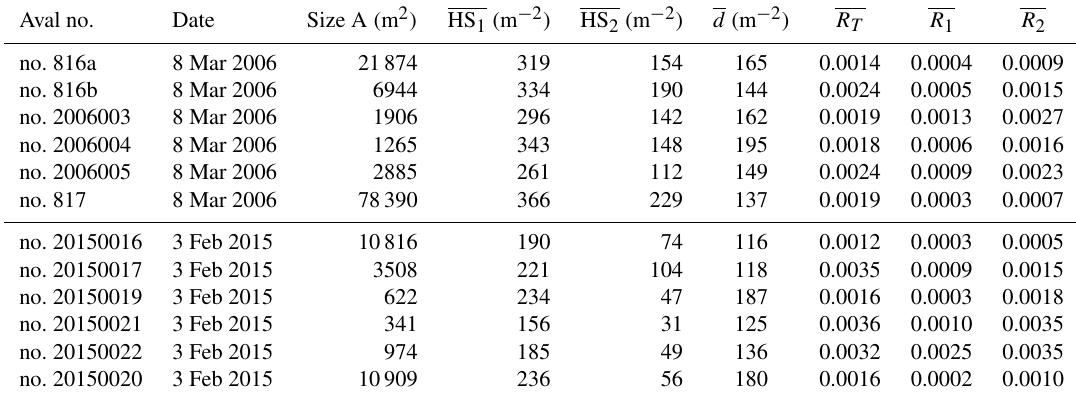
Table 3. Number, date, release area size ( A , mean snow depth before (HS 1 ) and after avalanche release (HS 2 ), mean fracture depth ( d ), mean roughness of the snow-free terrain ( R T ), the snow surface before avalanche release ( R 1 ) and the bed surface after avalanche release ( R 2 ) for all avalanche release areas with ALS measurements in VdlS. Aval